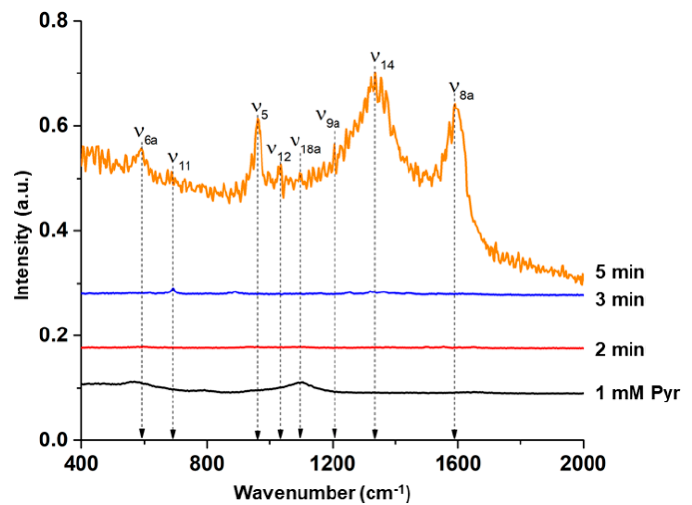
Figure 12. Surface-enhanced Raman spectroscopy (SERS) spectra of 1 nM pyridine on supports doped at 2, 3, and 5 min with 10 mM AgNO 3 at 1.5 V, and Raman spectra of 1 mM pyridine (black).